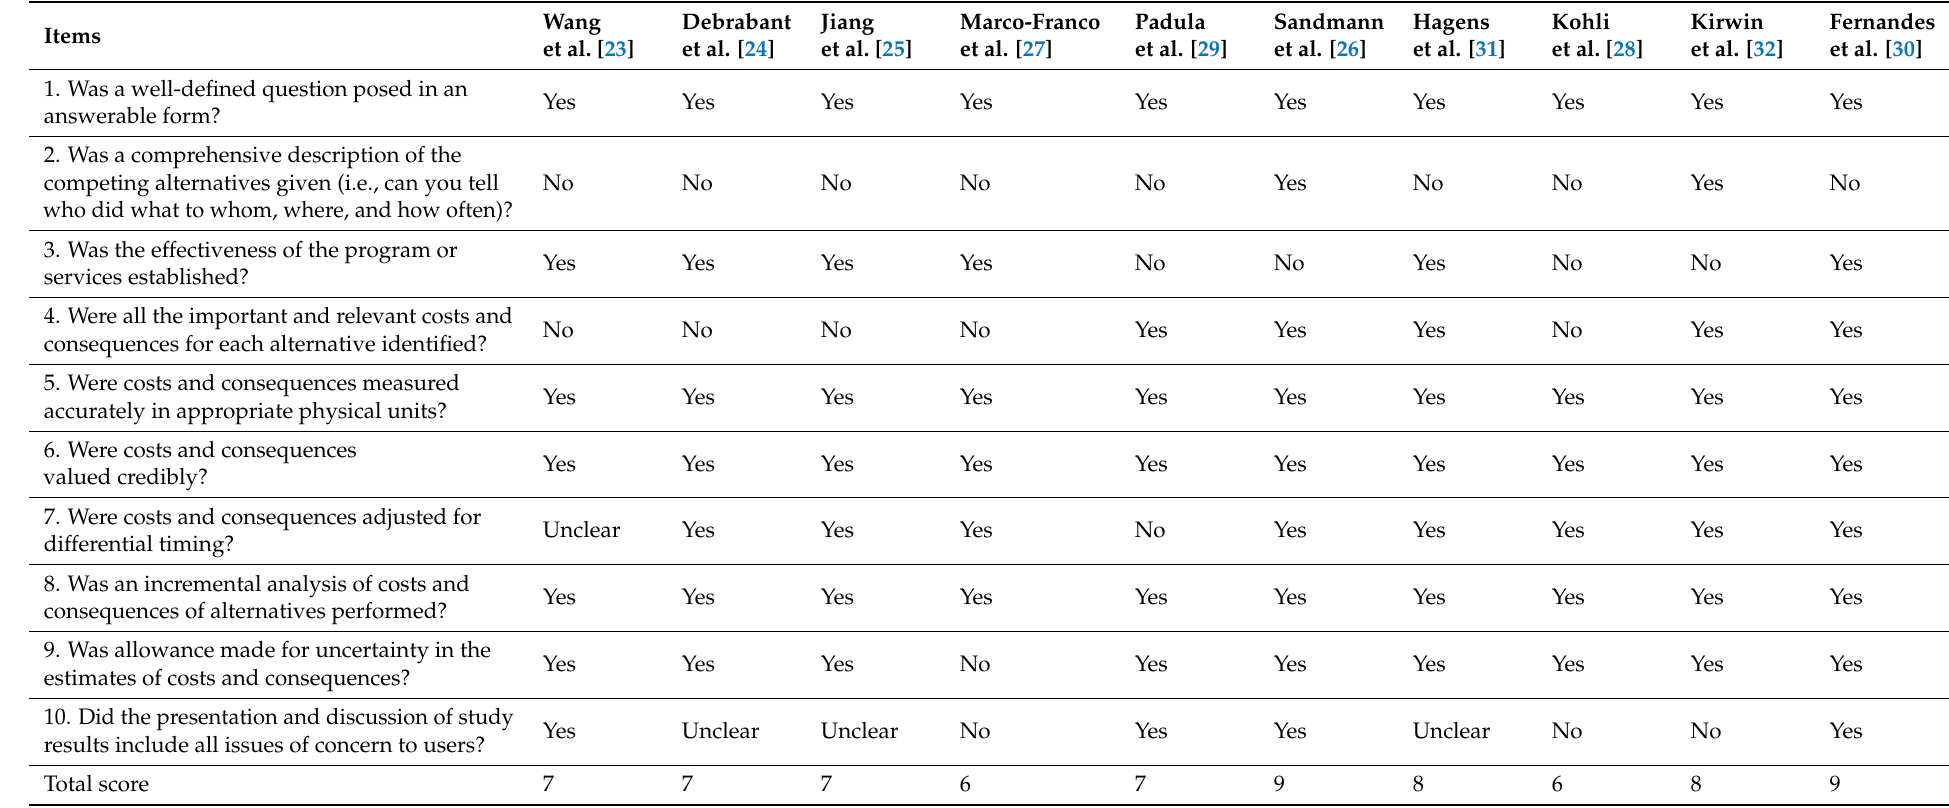
Table 2. Quality assessment of the included economic